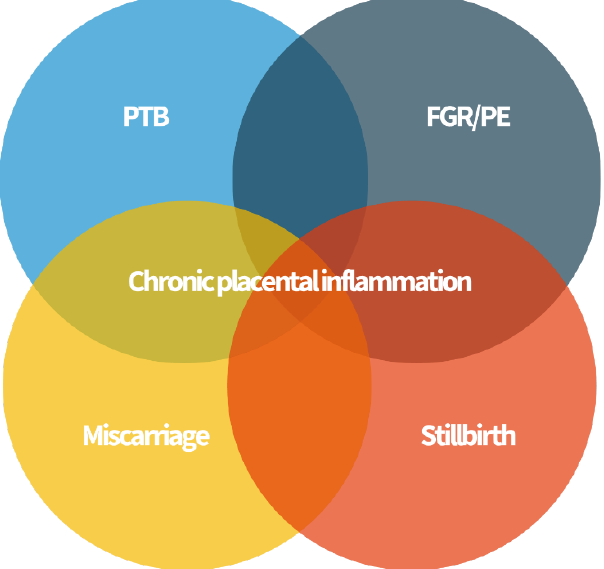
Figure 2. Chronic placenta inflammation is found in some cases of preterm birth (PTB), fetal growth restriction (FGR) and preeclampsia (PE), miscarriage, and stillbirth. These “great obstetrical syn- dromes” may share a common pathophysiology .